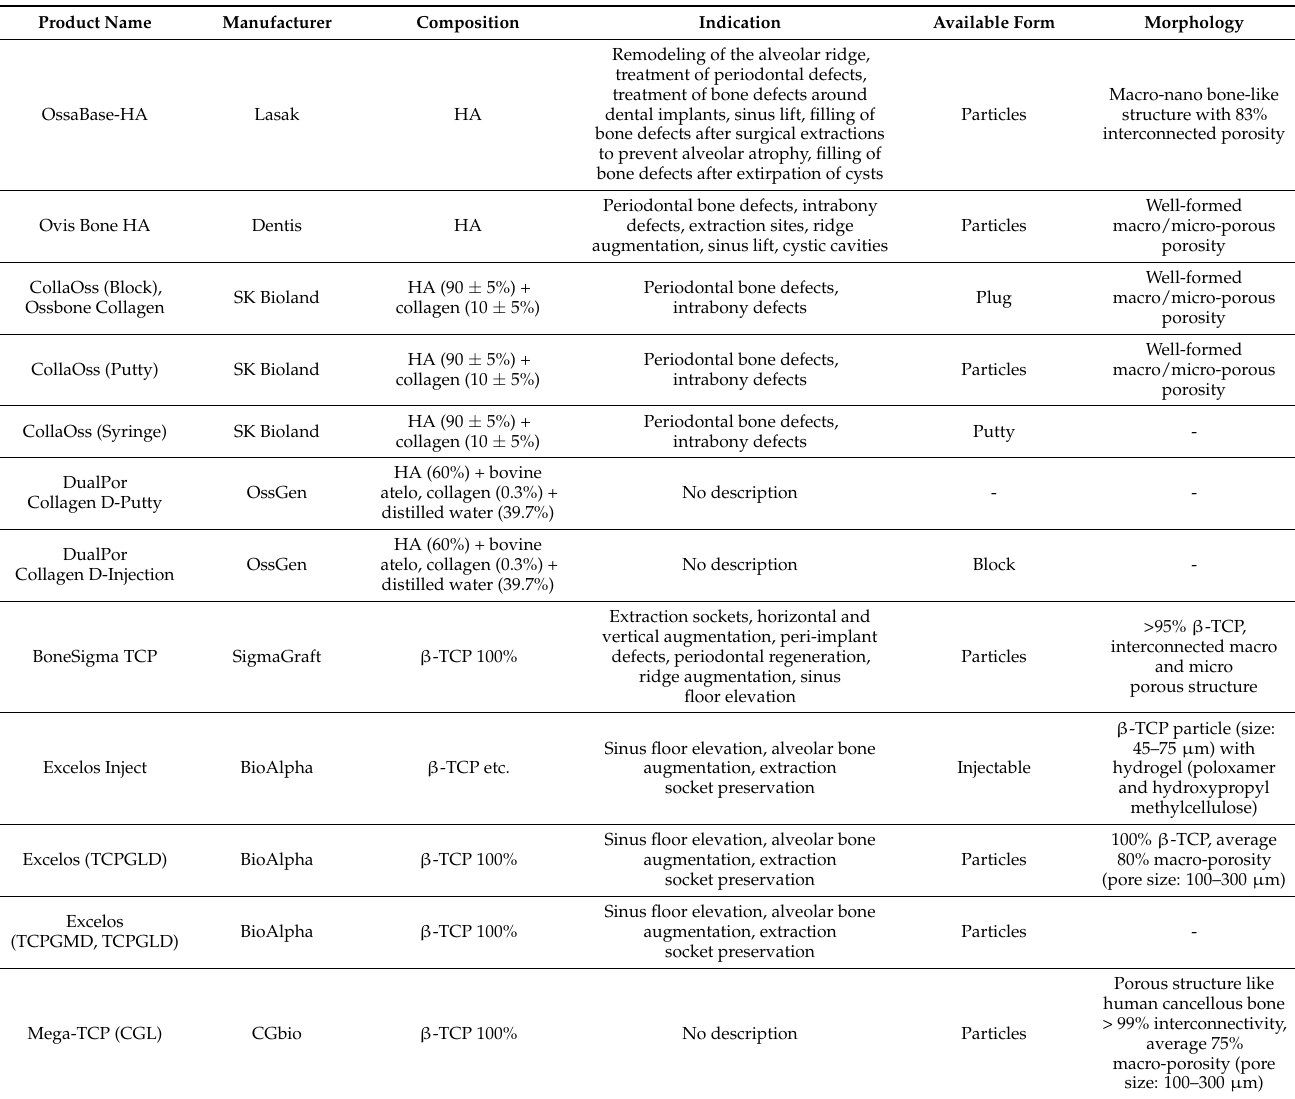
Table 3. Dental alloplastic bone substitute products for periodontal and oral implant applications approved by the Korean Health Insurance Review and Assessment